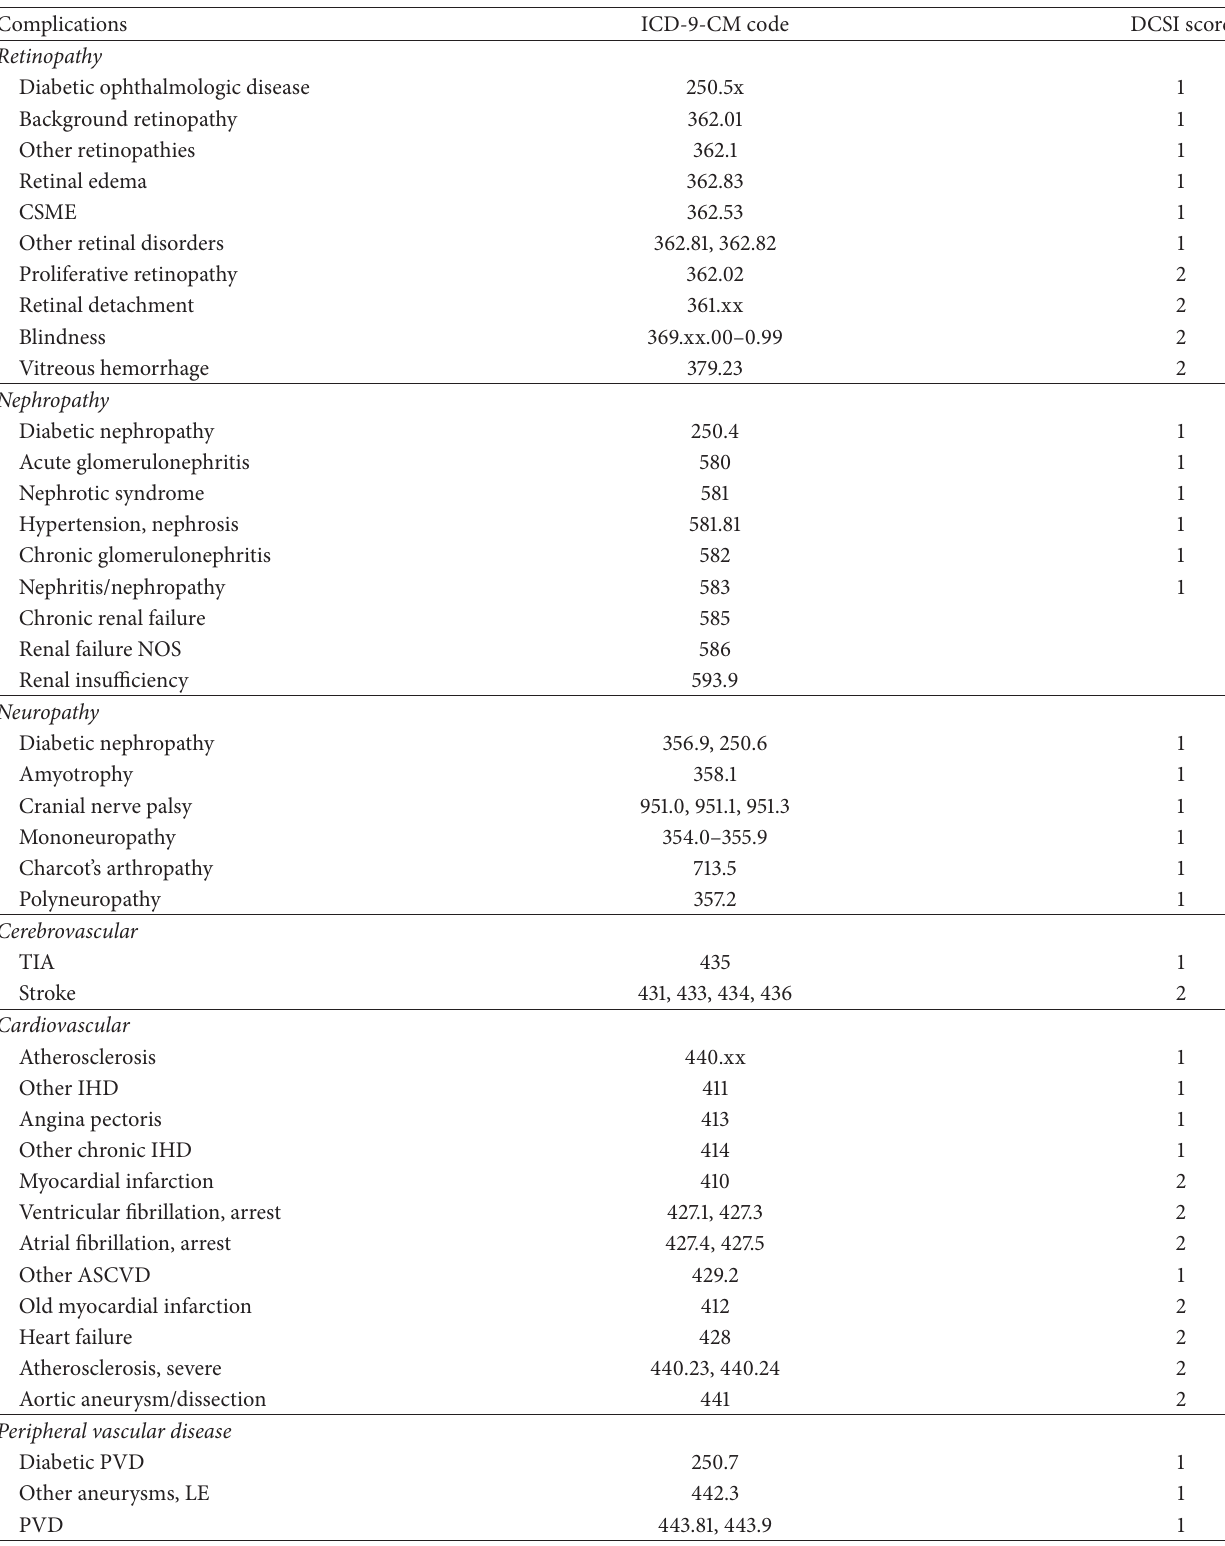
Table 4: Codes and algorithms to identify diabetes complication severity index (DCSI) developed by Young et al. and modified by Chang et